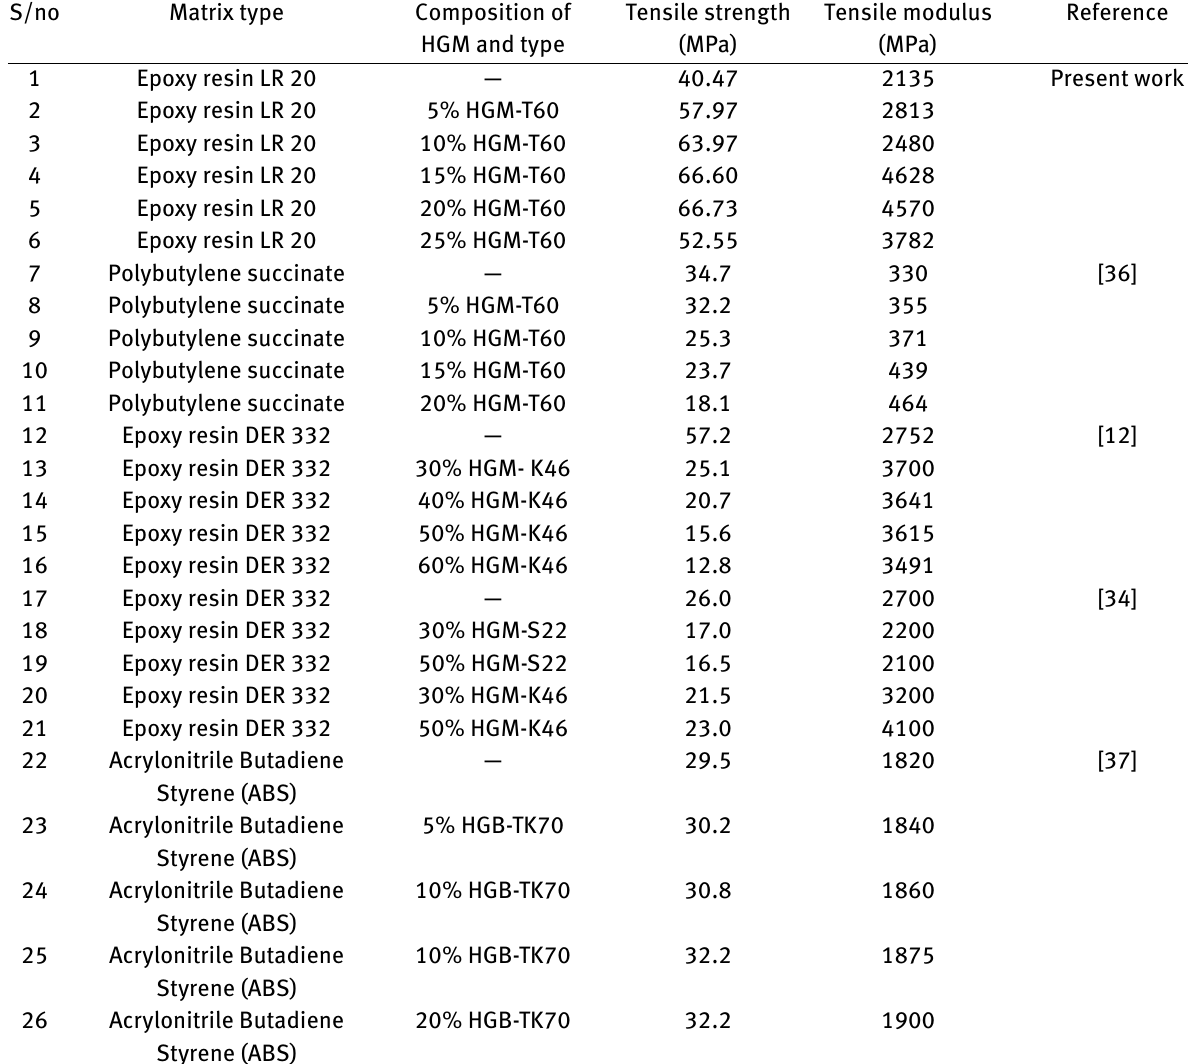
Table 4: Comparison of tensile properties of syntactic foam based on present work and existing literatures. S/no Matrix type Composition of Tensile strength HGM and type